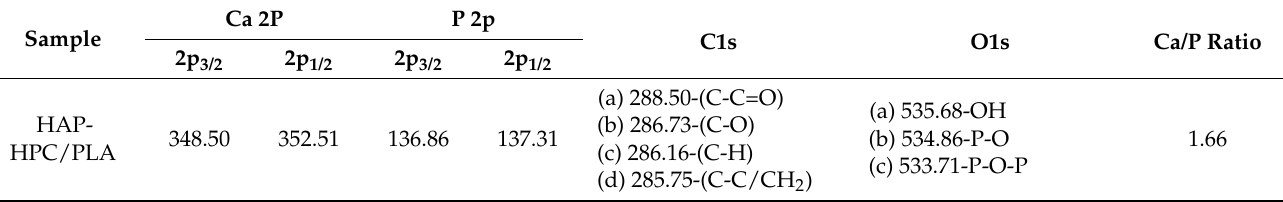
Table 4. The binding energy of XPS spectra peak for HAP-HPC/PLA.